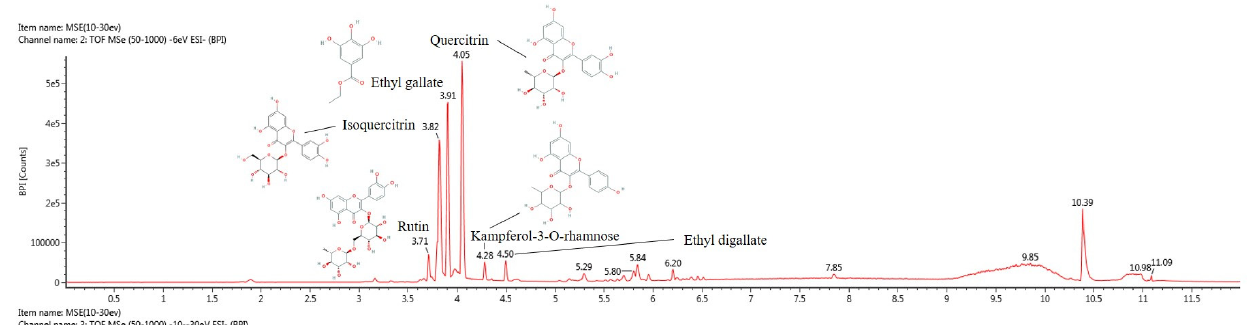
Figure 2. UPLC Q – TOF/MSE chromatography in negative ion mode of ethyl acetate fraction from Figure 2. UPLC Q–TOF/MSE chromatography in negative ion mode of ethyl acetate fraction from Cedrela sinensis (EFCS). Cedrela sinensis